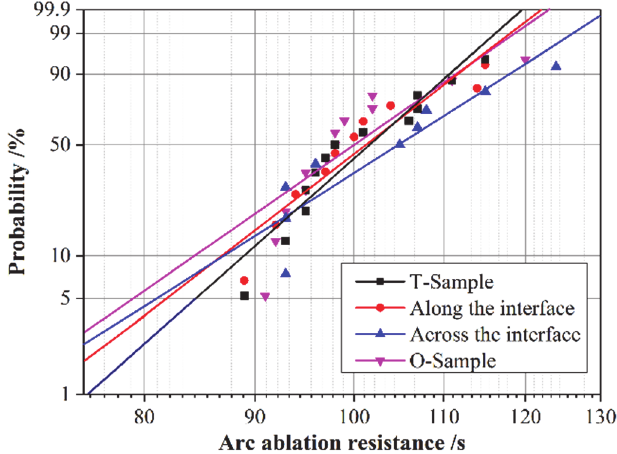
Figure 10. Weibull distribution of the arc ablation resistance of the different samples. Table 4. Weibull distribution parameters of arc ablation resistance of di ff erent